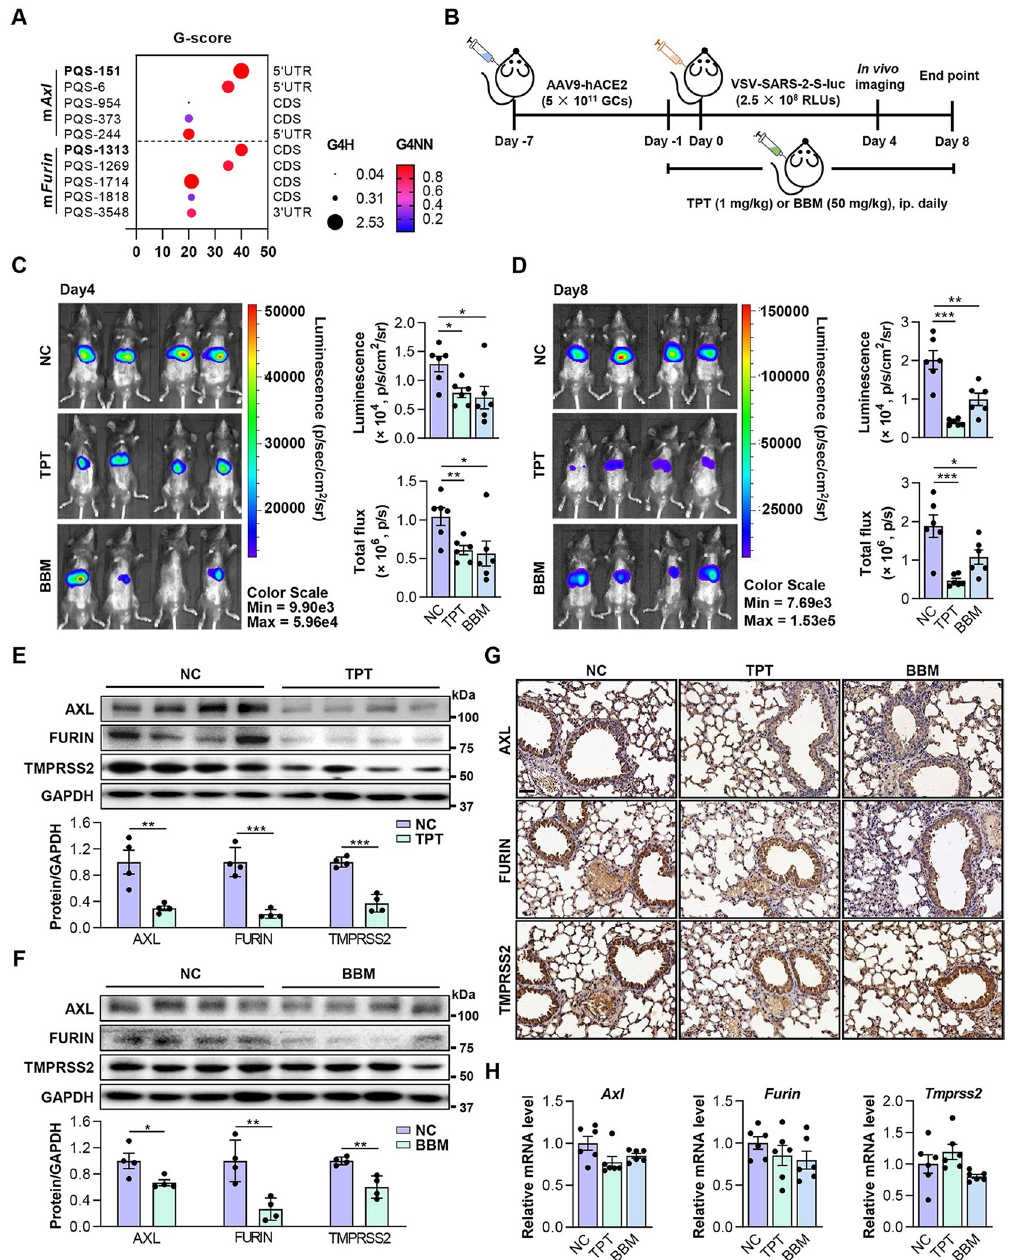
Fig 5. TPT and BBM impede SARS-CoV-2 pseudovirus entry in mice. (A) RG4 potential of mouse Axl and Furin mRNAs. PQSs conserved between human and mouse are indicated in bold . (B) Schematic of a mouse model for SARS-CoV-2 pseudovirus infection. C57BL/6J mice were transduced intrathoracic with the human ACE2-expressing adenovirus (AAV9-hACE2) and infected with VSV-SARS-2-S-luc after 7 days. Mice received daily peritoneal injections of TPT (1 mg/kg), BBM (50 mg/kg), or vehicle for 9 days from -1 day before VSV-SARS-2-S-luc infection. Following measurements were performed on day 4 and 8 post-infection (n = 6). (C, D) Representative photos of mice on day 4 (C) and 8 (D) post-infection (n = 6). Relative levels of bioluminescence are shown in pseudocolours, with blue and red representing the weakest and strongest photon fluxes, respectively. Photon emission from each mouse was quantified as luminescence (p/s/cm2/sr) and total flux (p/s) post imaging, respectively. (E, F) Protein levels of AXL, FURIN and TMPRSS2 in lungs of VSV-SARS-2-S-luc- infected mice treated with TPT (E) or BBM (F) (upper panel) (n = 4). ImageJ quantification of the target/GAPDH ratio is shown (bottom panel). (G) IHC staining for AXL, FURIN and TMPRSS2 in paraffin lung sections. Scale bars: 50 μ m. (H) mRNA levels of Axl , Furin , and Tmprss2 in lungs of VSV-SARS-2-S-luc-infected mice treated with TPT or BBM (n = 6). Data are shown as mean ± SEM, n = 4–6. � p < 0.05, �� p < 0.01, ��� p < 0.001 (Two-tailed Student’s t test). Fig 5B was created using Microsoft PowerPoint and Adobe Illustrator.